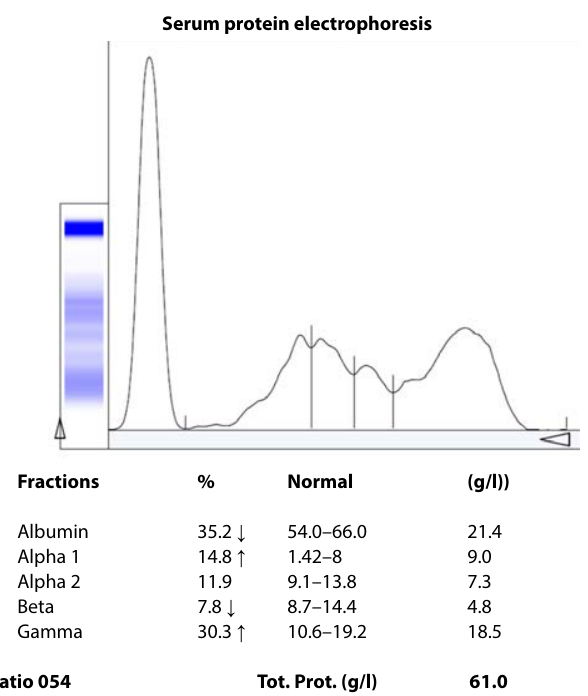
Figure 1: Serum protein electropherogram supplied by the commercial veterinary laboratory with the agarose gel strip to the left and the densitometer trace on the right. The reference ranges are human and should be ignored. There is a small alpha 1 globulin spike. Beta globulins and gamma globulins are within feline reference ranges (Taylor et al. 2010). The mild hypoalbuminaemia combined with the alpha one spike are consistent with an acute phase